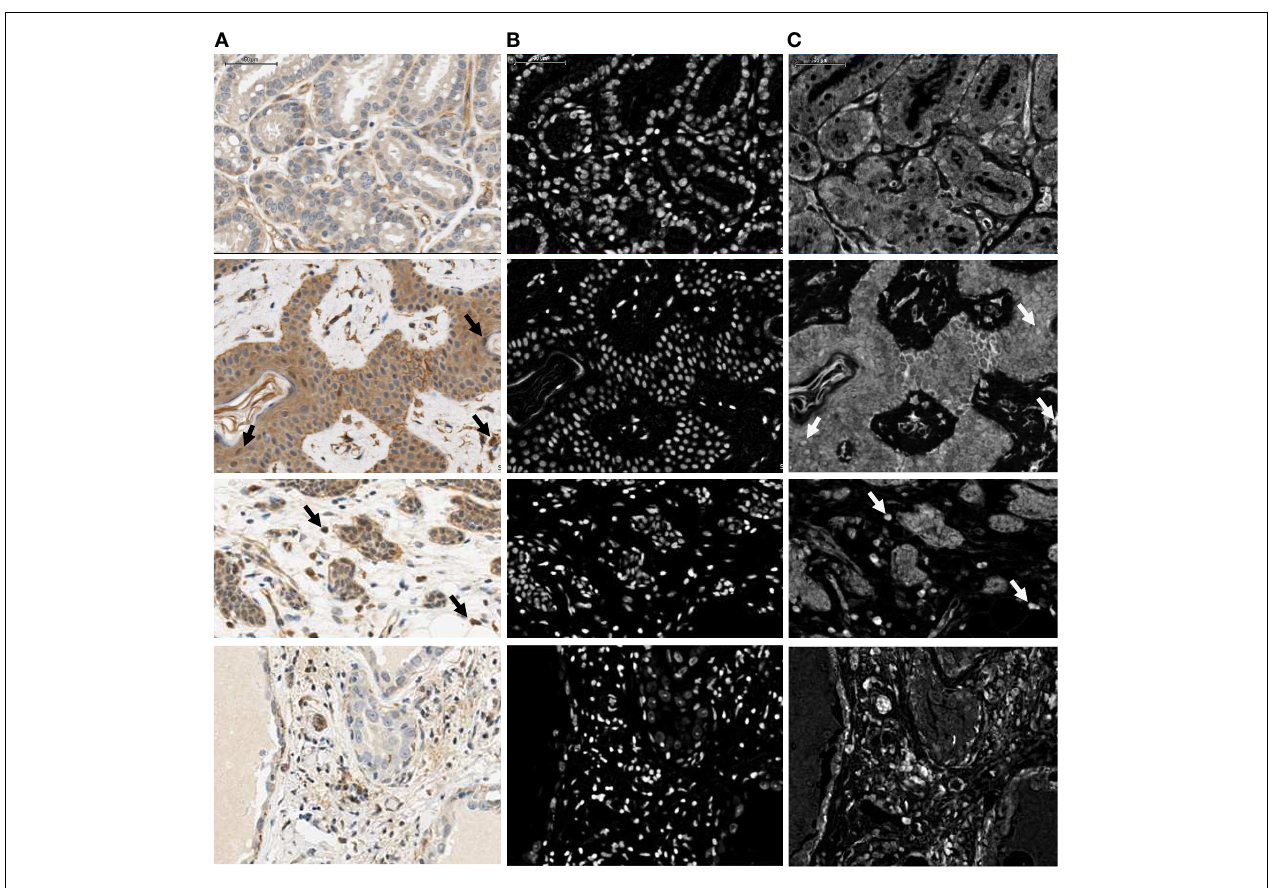
complete image data set. Raw images (A) and corresponding nuclear [hematoxylin; (B) ] and IHC [DAB; (C) ] stained layers are shown. Arrows indicate examples of positive nuclei. Scale bar: 50 µ